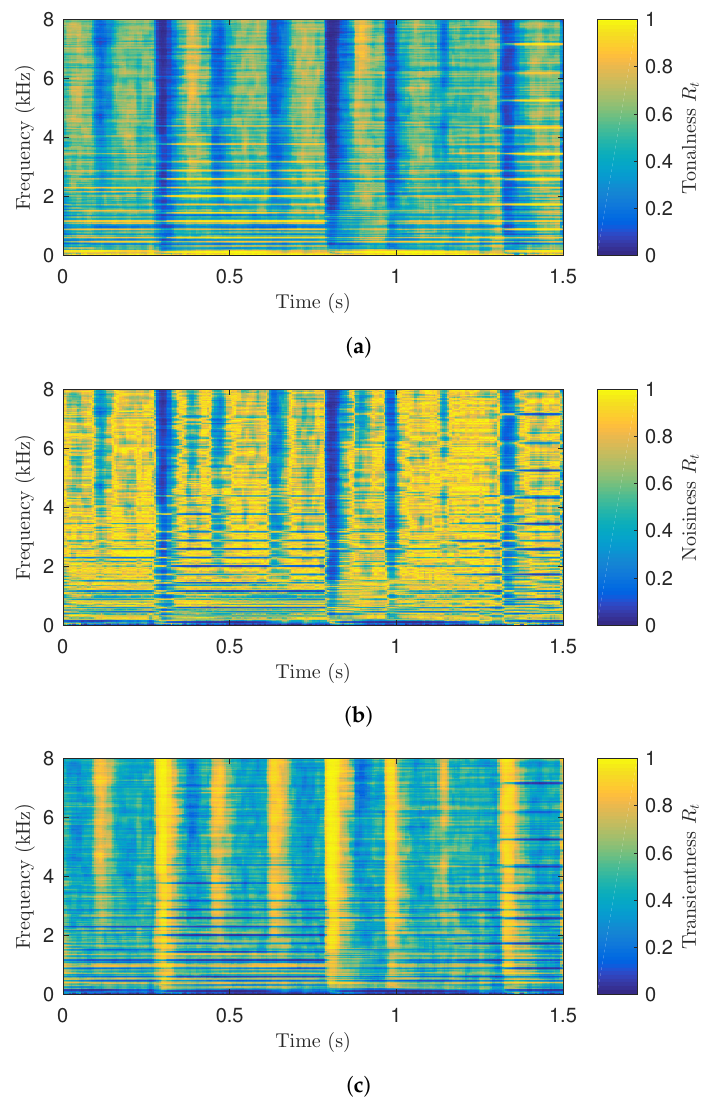
Figure 4. ( a ) Tonalness, ( b ) noisiness, and ( c ) transientness values for the short-time Fourier transform (STFT) bins of the example audio signal. Cf. Figure